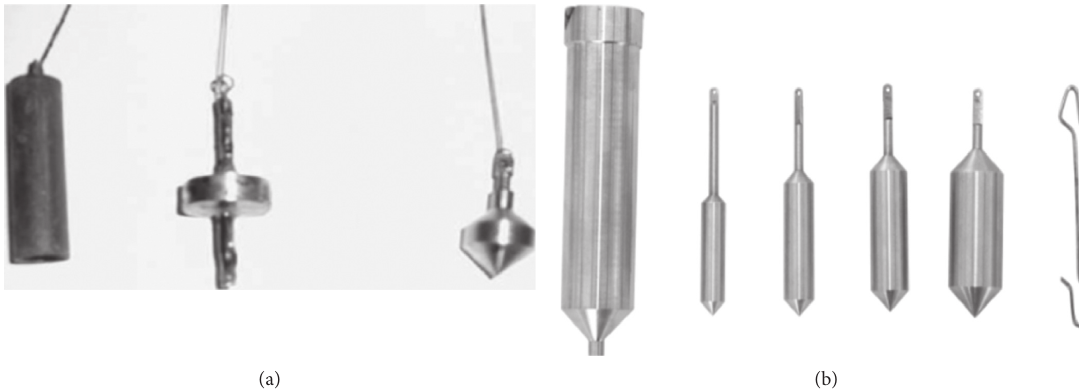
Figure 4: Shape of viscometer rotor. (a) Traditional rotor shape. (b) The rotor shape is selected in this paper.